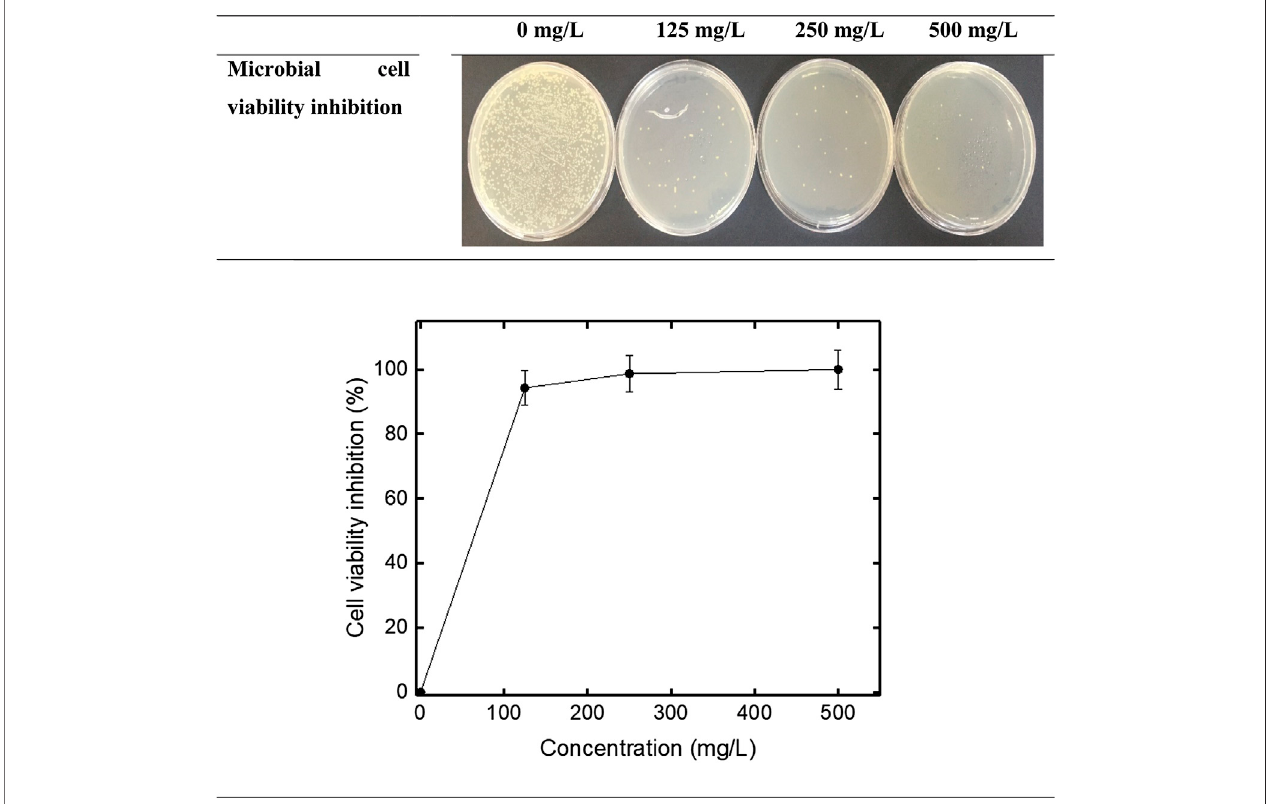
FIGURE 8 | Cell viability